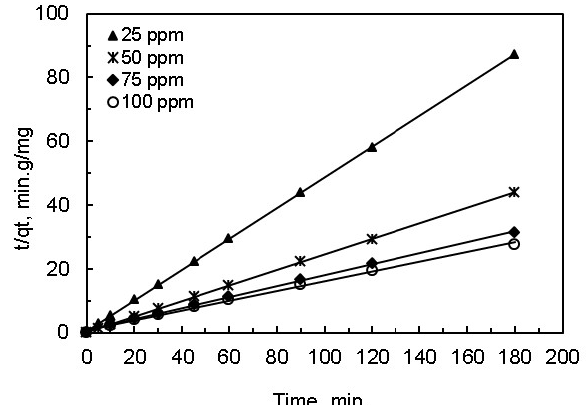
Fig. 8. The pseudo-second order kinetic plot for dye adsorption.